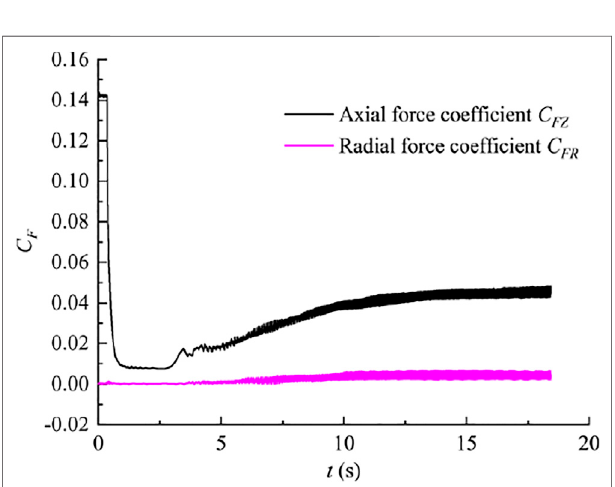
FIGURE 8 | Force coef fi cient variations with